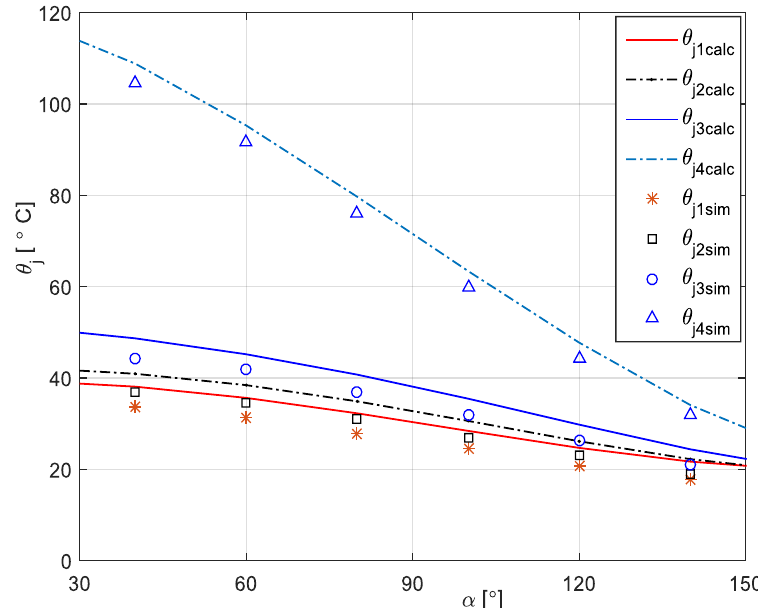
Figure 15. Junction temperature variation vs. firing angle at different load inductance values of 18; 30, 55, and 200 mH ( v air = 3 m/s; I = 200 A; R = 10 Ω).